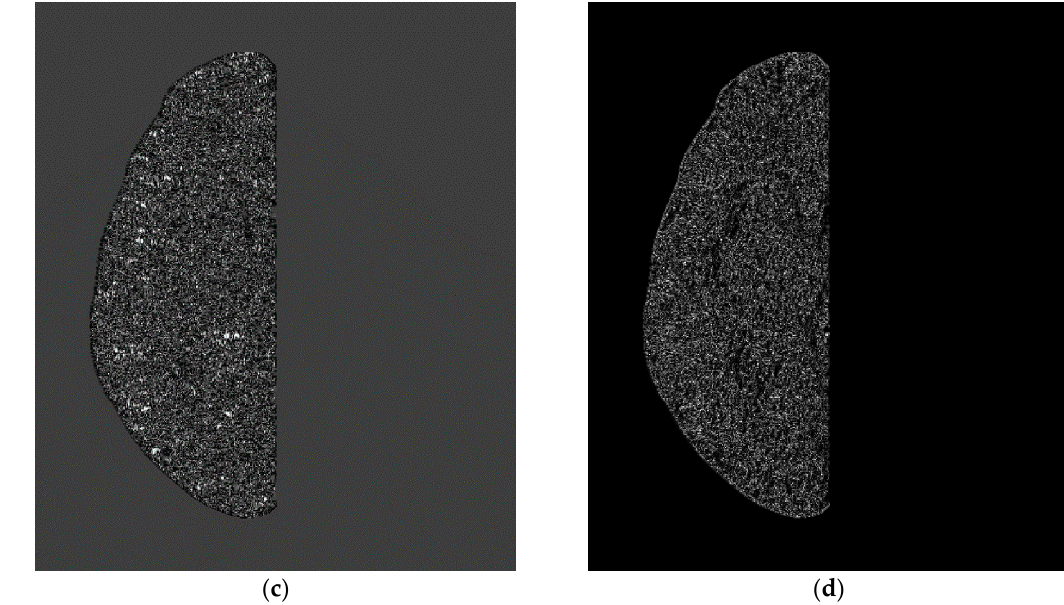
Figure 3. Original non-contrast computed tomographic (NCCT) image of the right side of a brain and the corresponding Ranklet coefficient images. ( a ) The original NCCT image, ( b ) the transformed horizontal image, ( c ) the transformed vertical image, and ( d ) the transformed diagonal image.